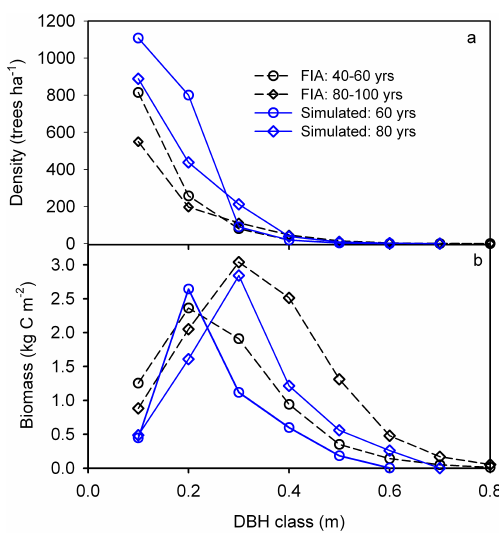
Figure 5. Distributions of tree size (a) and biomass (b) in different stand age classes. Black symbols with dashed lines are from the FIA data of the northern lake states, USA, and blue symbols with solid lines are from the three-species LM3-PPA simulations in Fig.